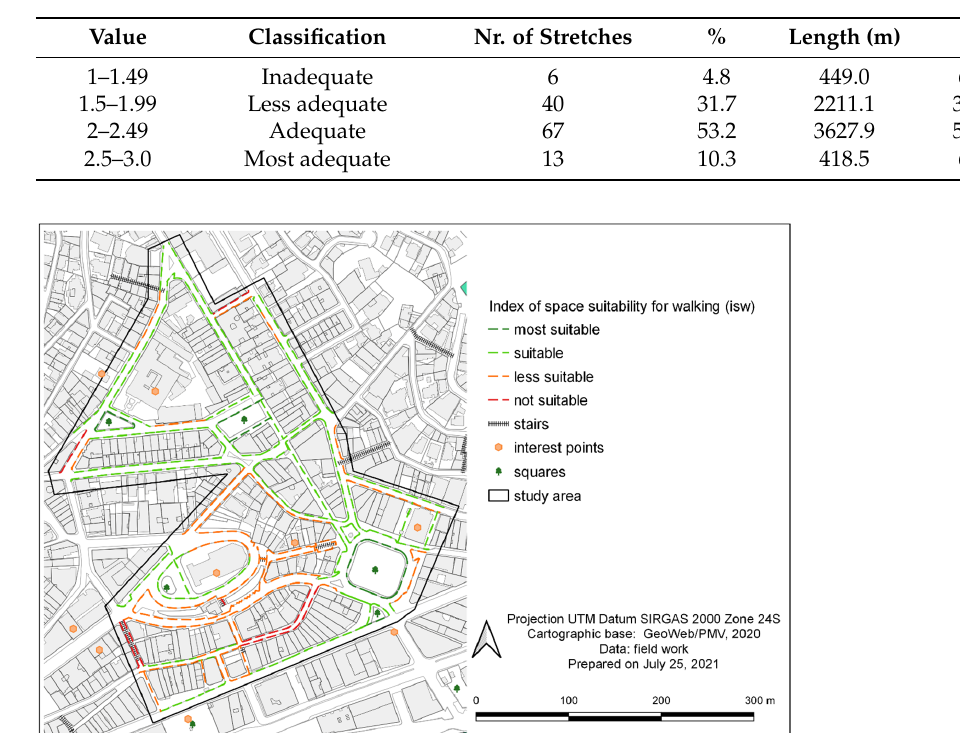
Figure 7. Map of the classification according to the walking space suitability index (‘isw’) in the study area.